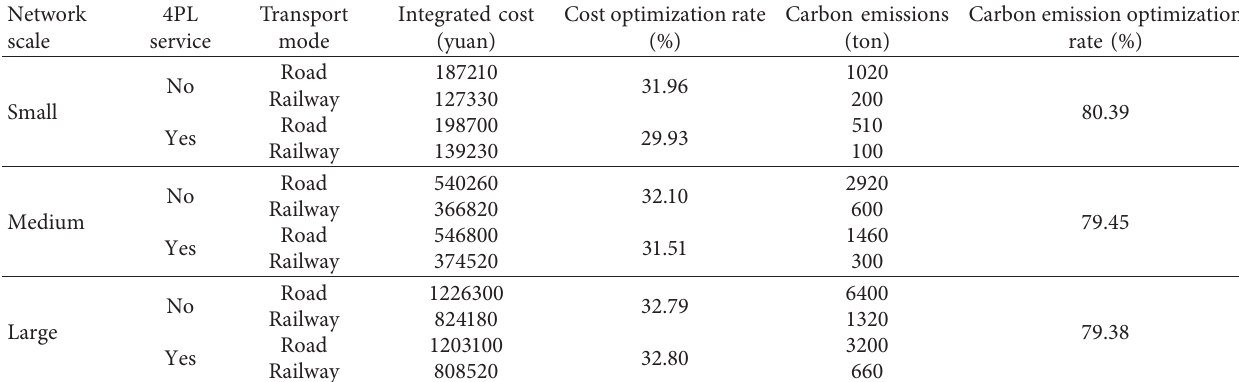
Table 14: Effect in bulk cargo transport networks of different